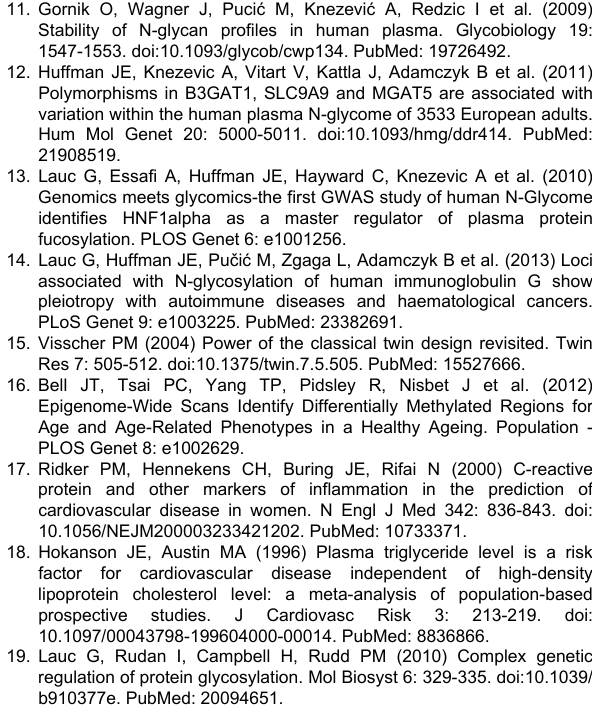
Table S3. List of loci associated with all glycans with high heritability (h 2